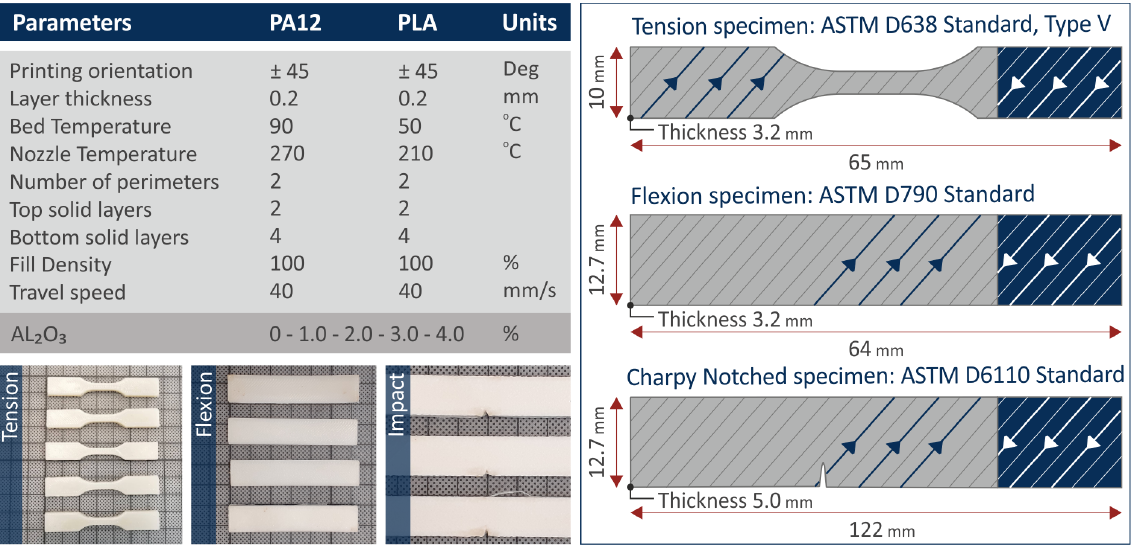
Figure 2. The optimal FFF 3DP parameters set up to the slicer software for the manufacturing of the neat PA12 and PLA and the Al 2 O 3 nanocomposites (real representative tension, flexural, and impact specimens are depicted).